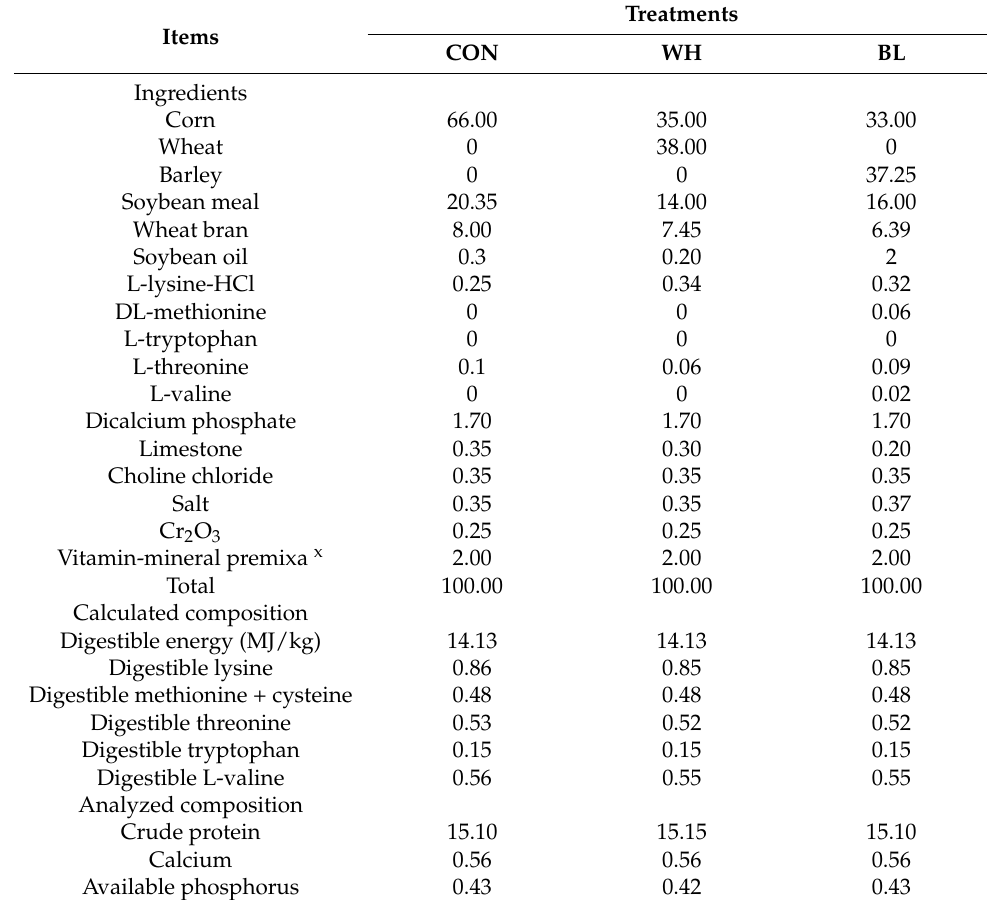
x Vitamin-mineral premix provided the following per kilogram of diets: vitamin A, 5512 IU; vitamin D vitamin E, 30 IU; vitamin K 3 , 2.2 mg; vitamin B 12 , 27.6 µ g; riboflavin, 4 mg; pantothenic acid, 14 mg; niacin, 30 mg; folic acid, 0.7 mg; thiamin, 1.5 mg; pyridoxine, 3 mg; biotin, 44 µ g. Fe(FeSO 4 · H 2 O) 50 mg; Mn(MnSO 4 ) 2 mg;